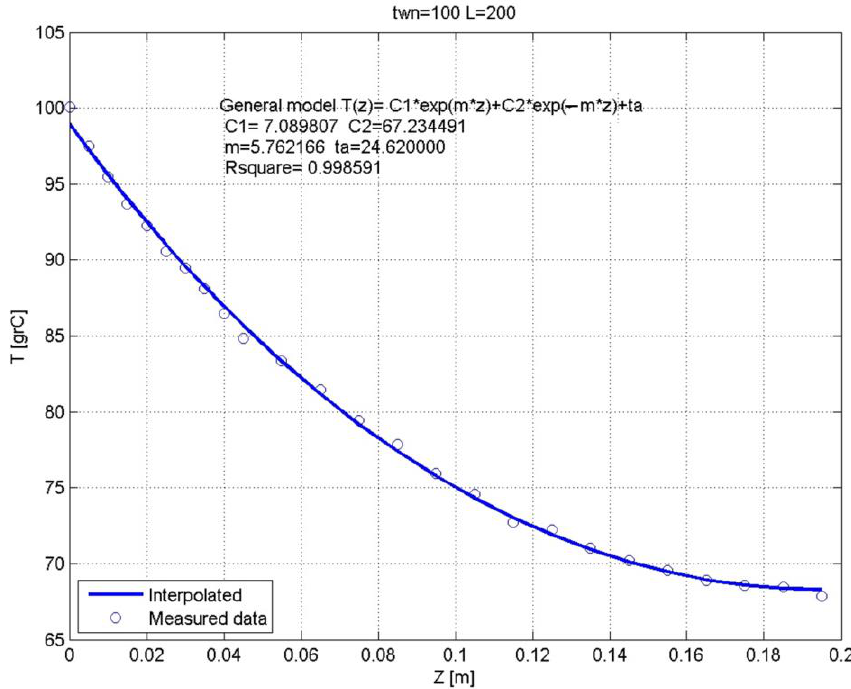
Figure 2. Classical (“exponential”) approach with LSM (for Equation (2)) compared with the experimentally measured data for t O , n = 100 ◦ C; α g = 0 ◦ .